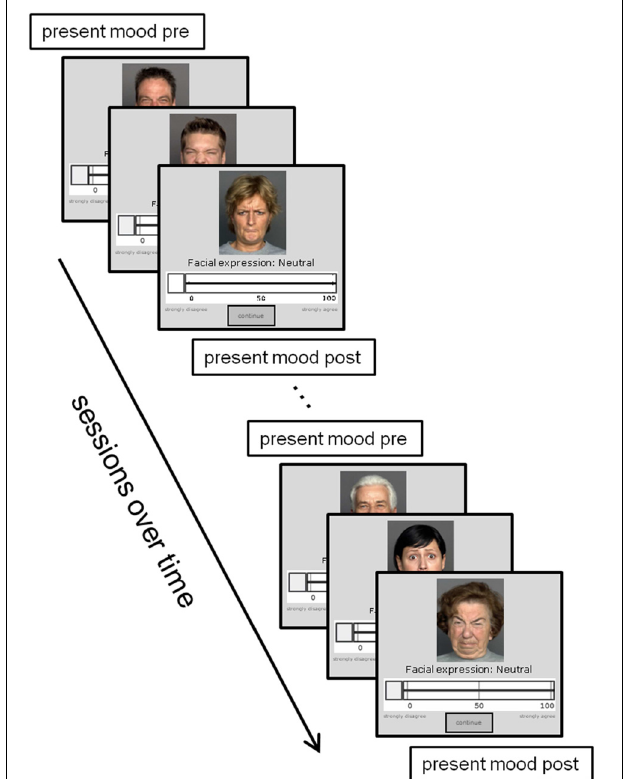
FIGURE 1 | Illustration of the study procedure. Present mood was assessed at the beginning and the end of each session. During each session, participants rated the emotional expression of different face pictures by adjusting a slider. In addition, the primary emotional expression (happiness, sadness, anger, disgust, fear, or neutrality) was assessed via categorical